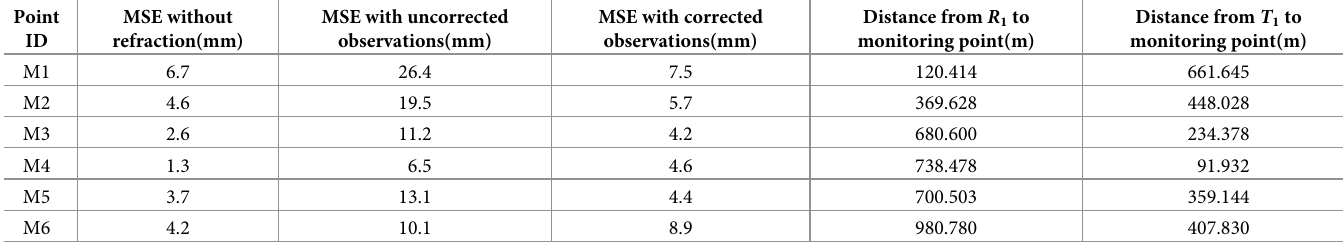
Table 1. Plane displacement accuracy comparison with observation correction.